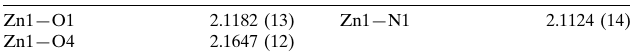
Selected bond lengths (A˚ ).